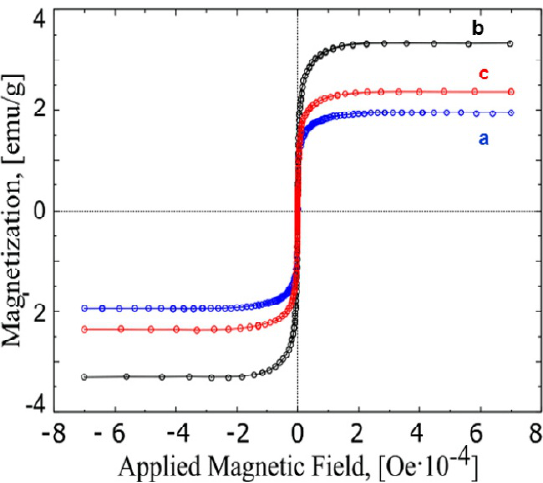
Fig. 6. Hysteresis-curves obtaind at 300K of SiO Mag-IBU samples prepared with molar ratios of a) 1:16, b) 1:8, c) 1:24, respectively.